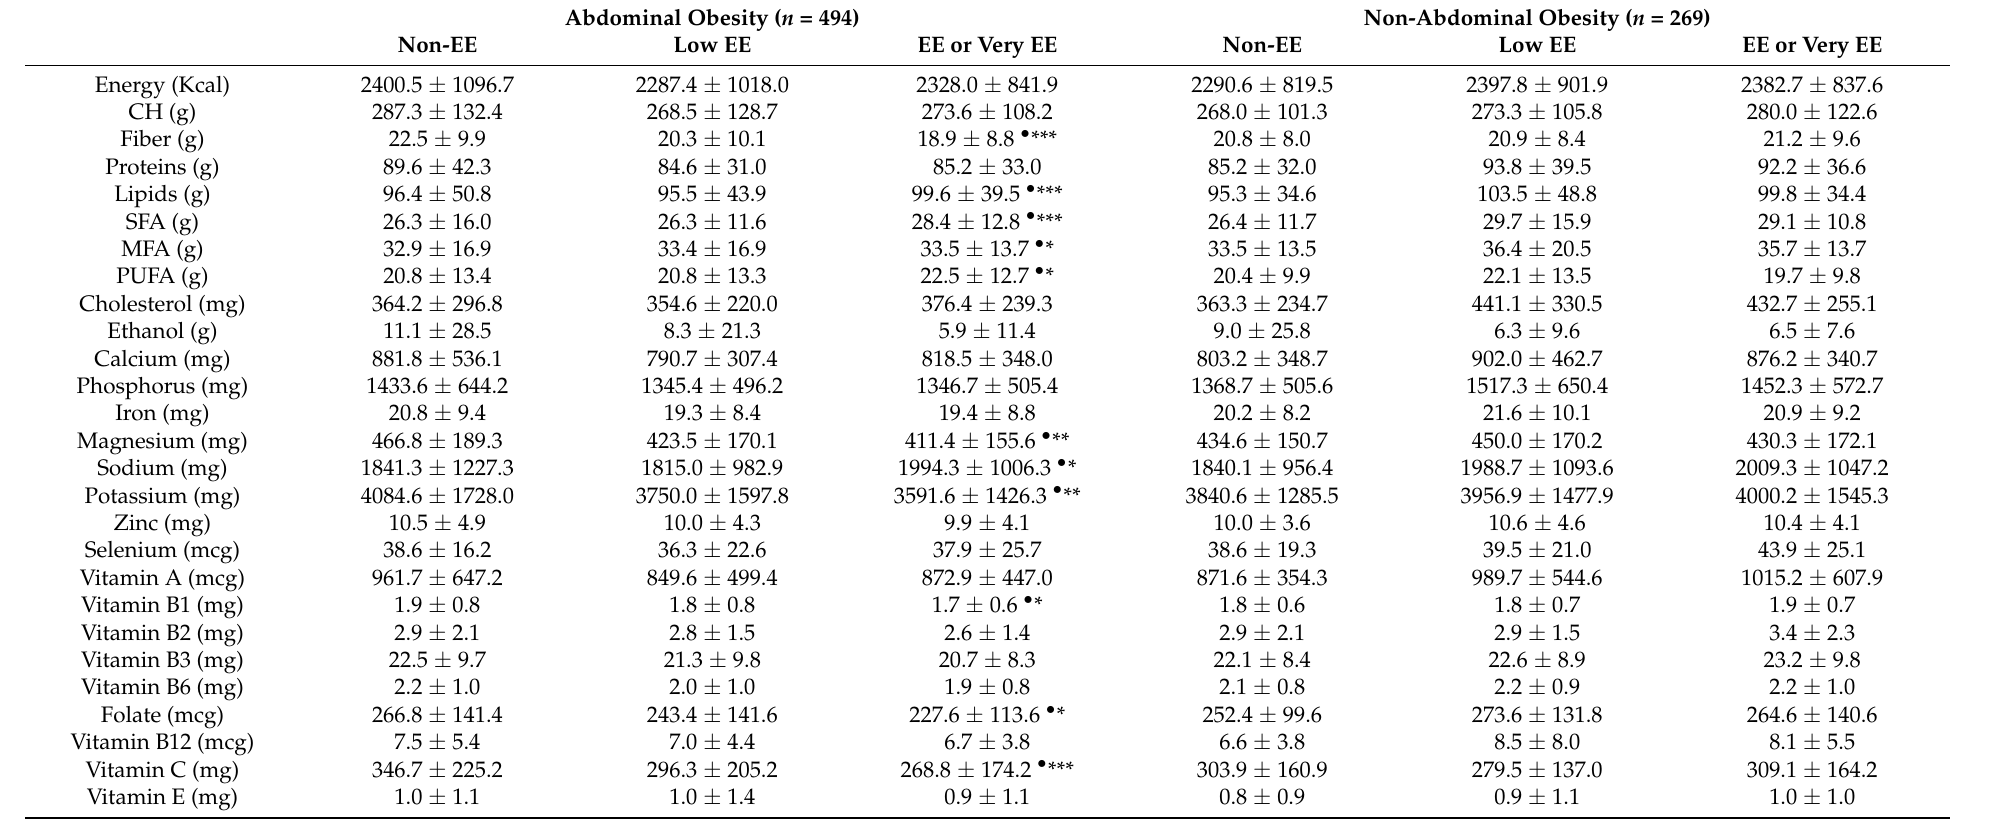
Table 5. Energy and nutrient intake according to emotional eater classification in participants with/without abdominal